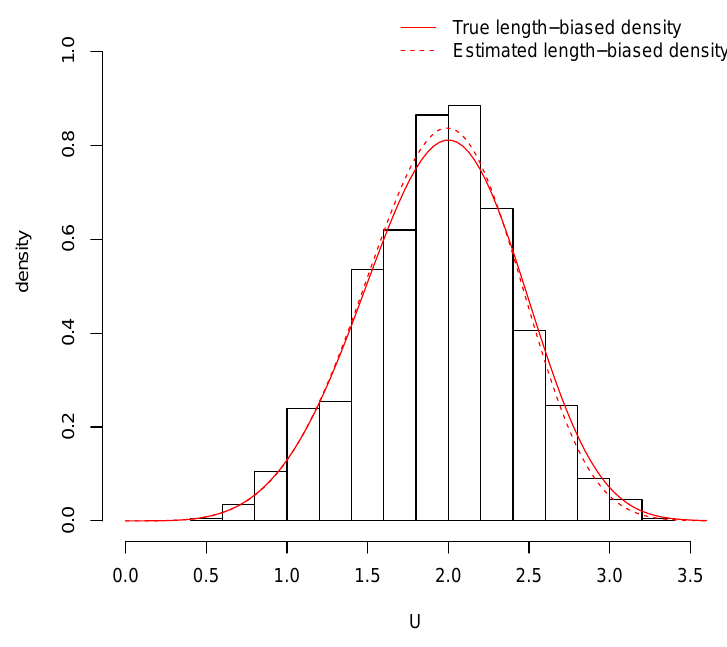
Figure 1: Observed frequencies of the length-biased survival times, true length-biased density GG ( r , p , 1 + r −1 ) and GG (ˆ r , ˆ p , ˆ k ) with N = 5000, n = 1000, r = 4, p = 2 and α =